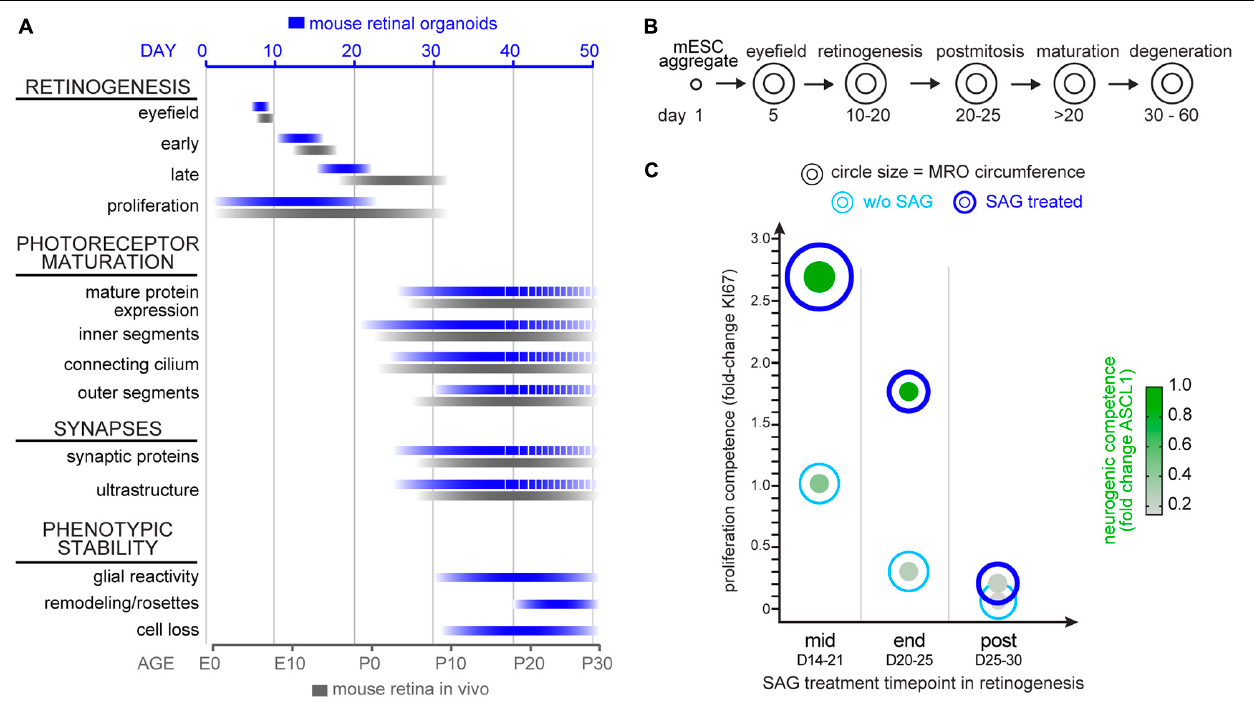
FIGURE 9 | Summary schemes of MRO maturation and SAG-induced enlargement. (A) Summary of the development and maturation timeline of mouse retinal organoids (MRO, blue bars) as observed in this study and previously reported (Völkner et al., 2016, 2019) and in comparison, to in vivo mouse retina (black bars). Dotted lines indicate incomplete MRO maturation and pathologic changes. E, embryonic day; P, postnatal day. (B) Summary schematic of the phases of MRO development. mESC form an aggregate after 1 day (D) in culture and cells acquire eyefield identity starting from D5. From D10 to D20 all major cell types of the retina are generated in a defined order in MRO (retinogenesis). MRO become postmitotic and mature upon further culture, particularly between D20 and D30. From D30, pathologic changes occur in the inner and outer retina. (C) Summary of the SAG-induced effect on MRO at the different timepoints. Data shown are summarized from Figure 8 : Circle diameter depicts MRO size based on organoid circumference. Proliferation competence depicted on the y-axis is based on KI67 data. Neurogenic competences presented as green dots is based on nuclear expression of ASCL1. Data presented were normalized to experiments started at mid retinogenesis (according to paradigms shown in Figure 8A